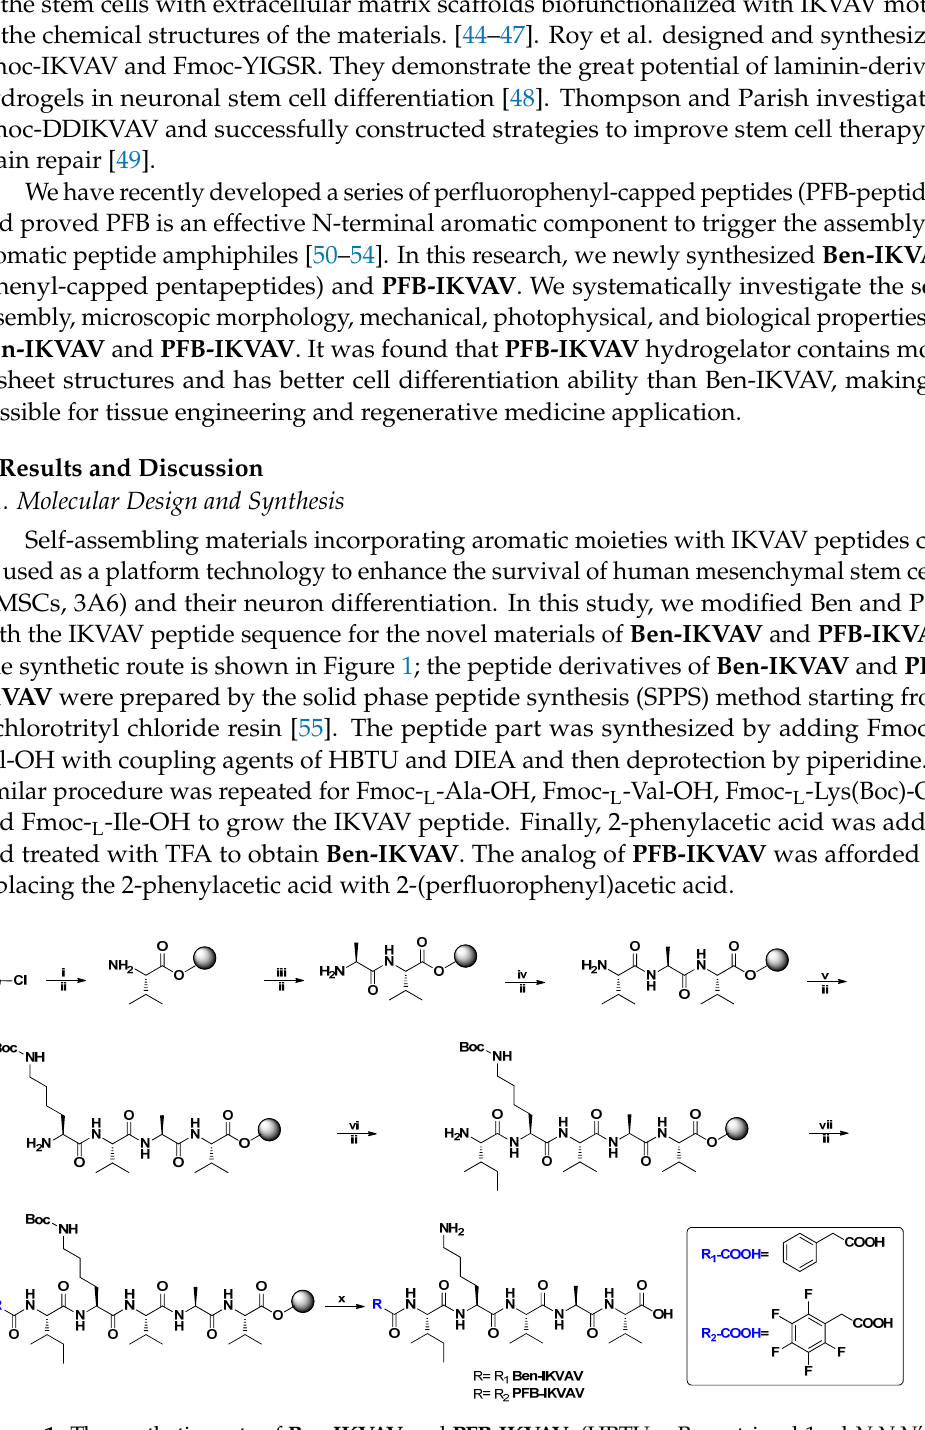
Figure 1. The synthetic route of Ben-IKVAV and PFB-IKVAV . (HBTU: o -Benzotriazol-1- yl- N,N,N’,N’ -tetramethyluronium hexafluorophosphate; DIEA: N,N -diisopropylethyl- amine; TFA: trifluoroacetic acid.).